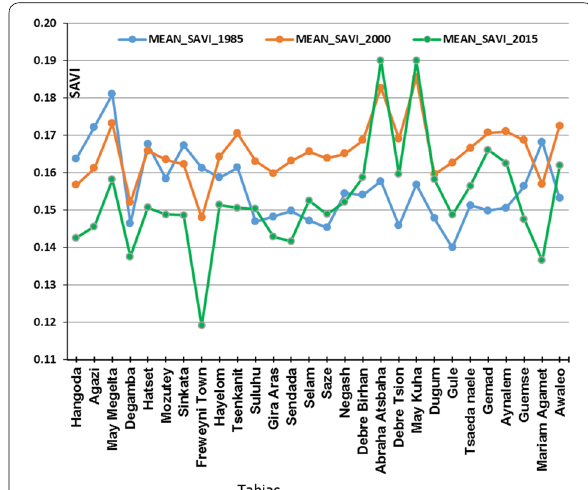
Fig. 4 Mean SAVI distribution in the village polygons in 1985, 2000 and